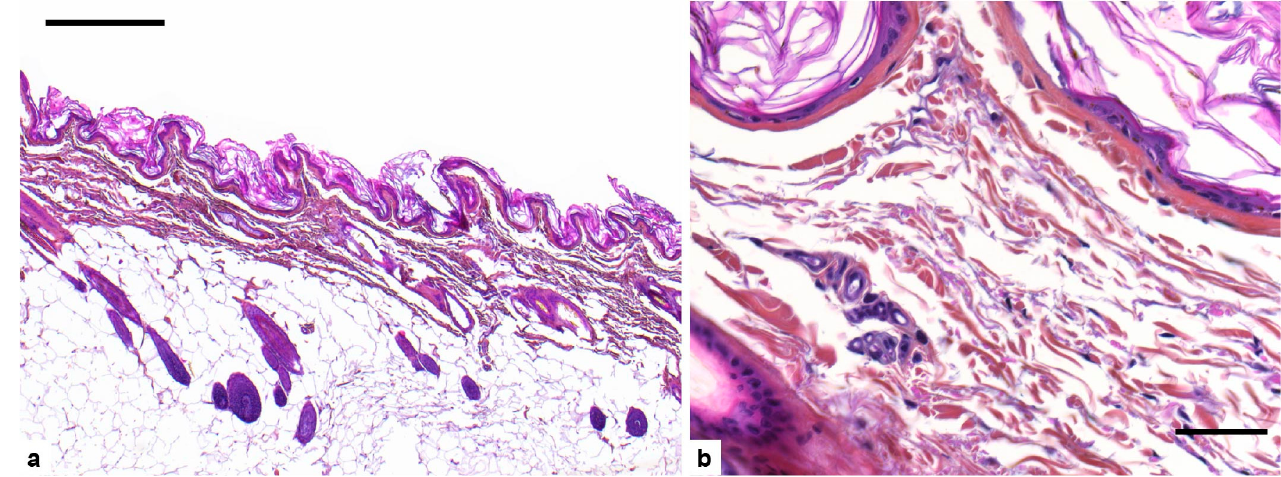
Figure 3. Cutaneous histopathological findings of the dog affected with Ehlers-Danlos syndrome (EDS). ( a ) Dermis is abnormally thin while epidermis and hypodermis are normal. Hematoxylin-eosin and saffron stain (HES), bar 500 µm; ( b ) collagen fibers are moderately uneven in size and their density is markedly reduced. Hematoxylin-eosin and saffron stain (HES), bar 50 µm.